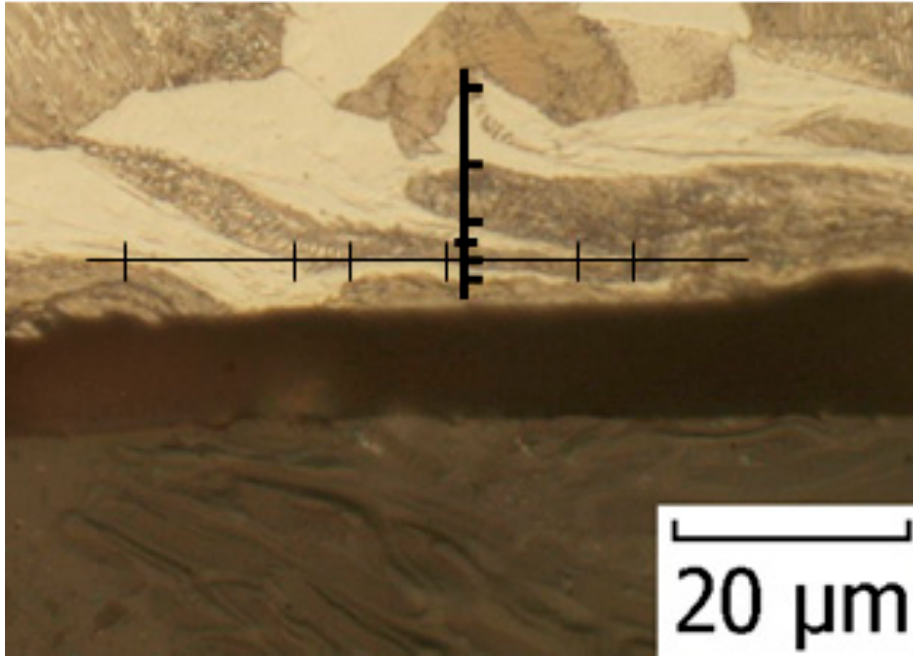
Figure 7. Test lines Placed perpendicular and parallel to the grain boundaries.